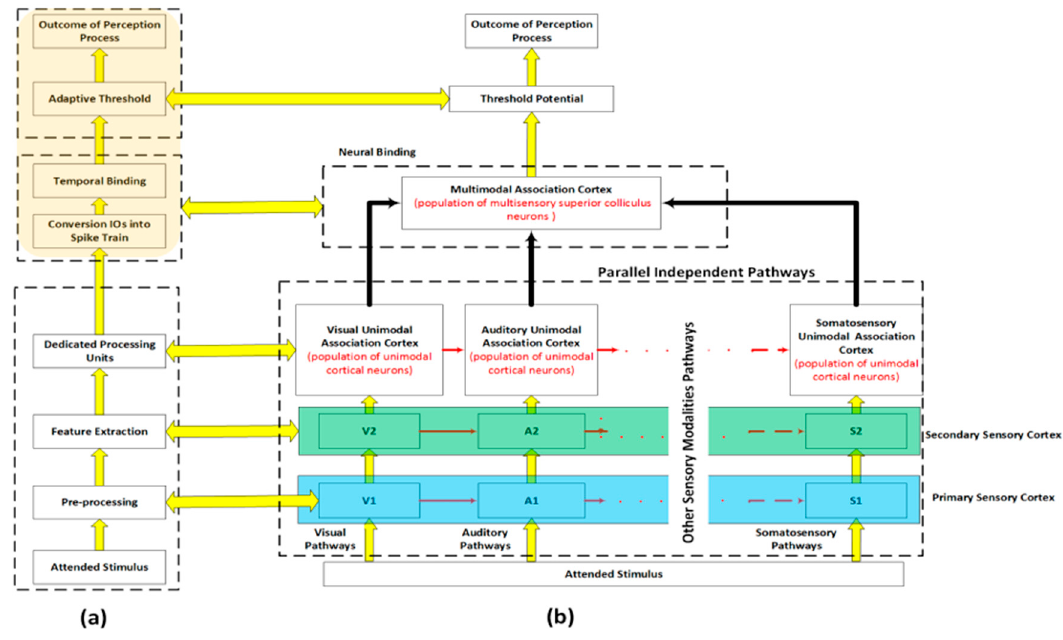
Figure 1. The proposed framework of brain-inspired multimodal perceptual system for social